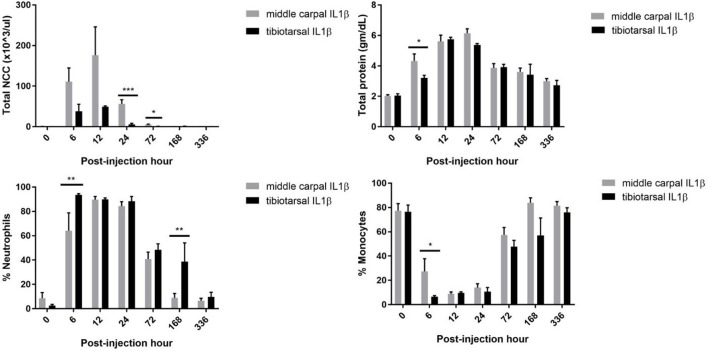
Cytologic analysis following IL1β administration. Total nucleated cell count (NCC) was higher at 24 PIH and 72 PIH when rIL-1β was administered into the MCJ. In contrast, the percent of neutrophils was increased in the TTJ when compared to the MCJ at both 6 PIH and 168 PIH. Error bars represent SEMs of the mean and significance is indicated by *(P < 0.05), **(P < 0.01), and ***(P < 0.001).